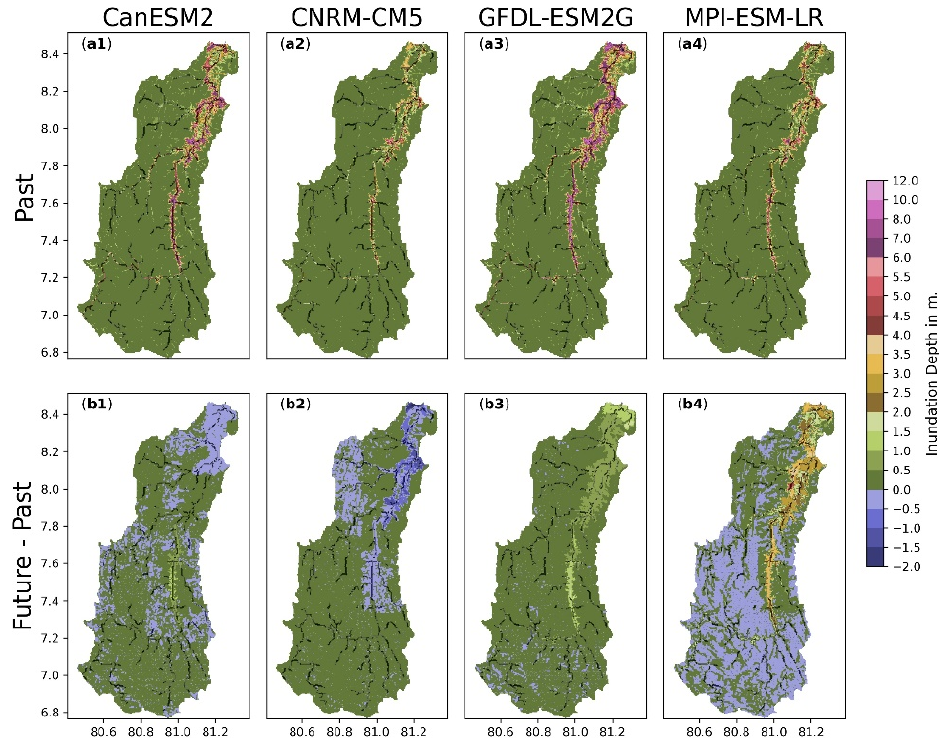
Figure 12. ( a ) Past all-time inundation depth; and ( b ) inundation depth deference between future and past of the selected GCMs: CanESM2 ( a1 , b1 ), CNRM-CM5 ( a2 , b2 ), GFDL-ESM2G ( a3 , b3 ), MPI-ESM-LR ( a4 , b4 ).